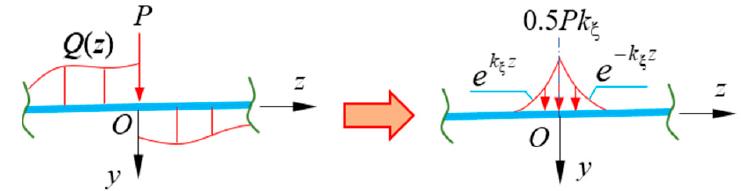
Figure 5. Equivalent analysis of shear discontinuities.